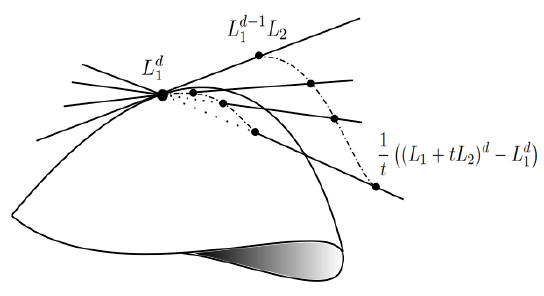
Figure 1. Representation of